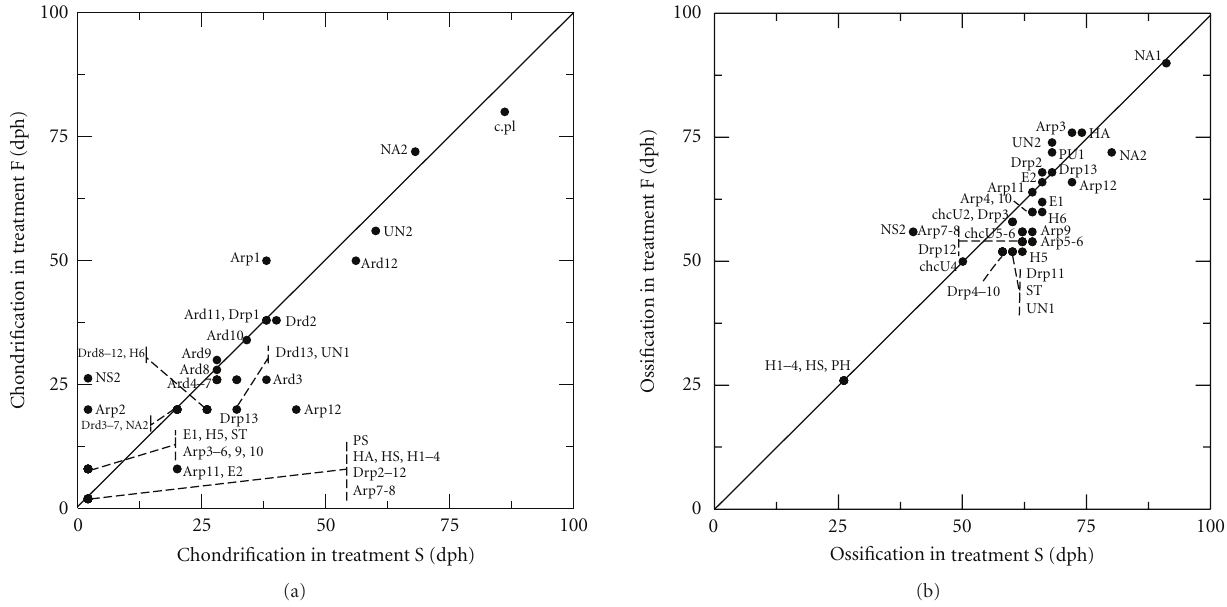
Figure 4: Biplots of the absolute timing of chondrification (a) and ossification (b) for all postcranial elements studied in Salvelinus alpinus between day 2 and 90. The synchrony line corresponds to a simultaneous appearance of elements in both treatments. Elements figuring above the line are those forming in Treatment S before Treatment F, whereas the elements below the line form earlier in Treatment F than in Treatment